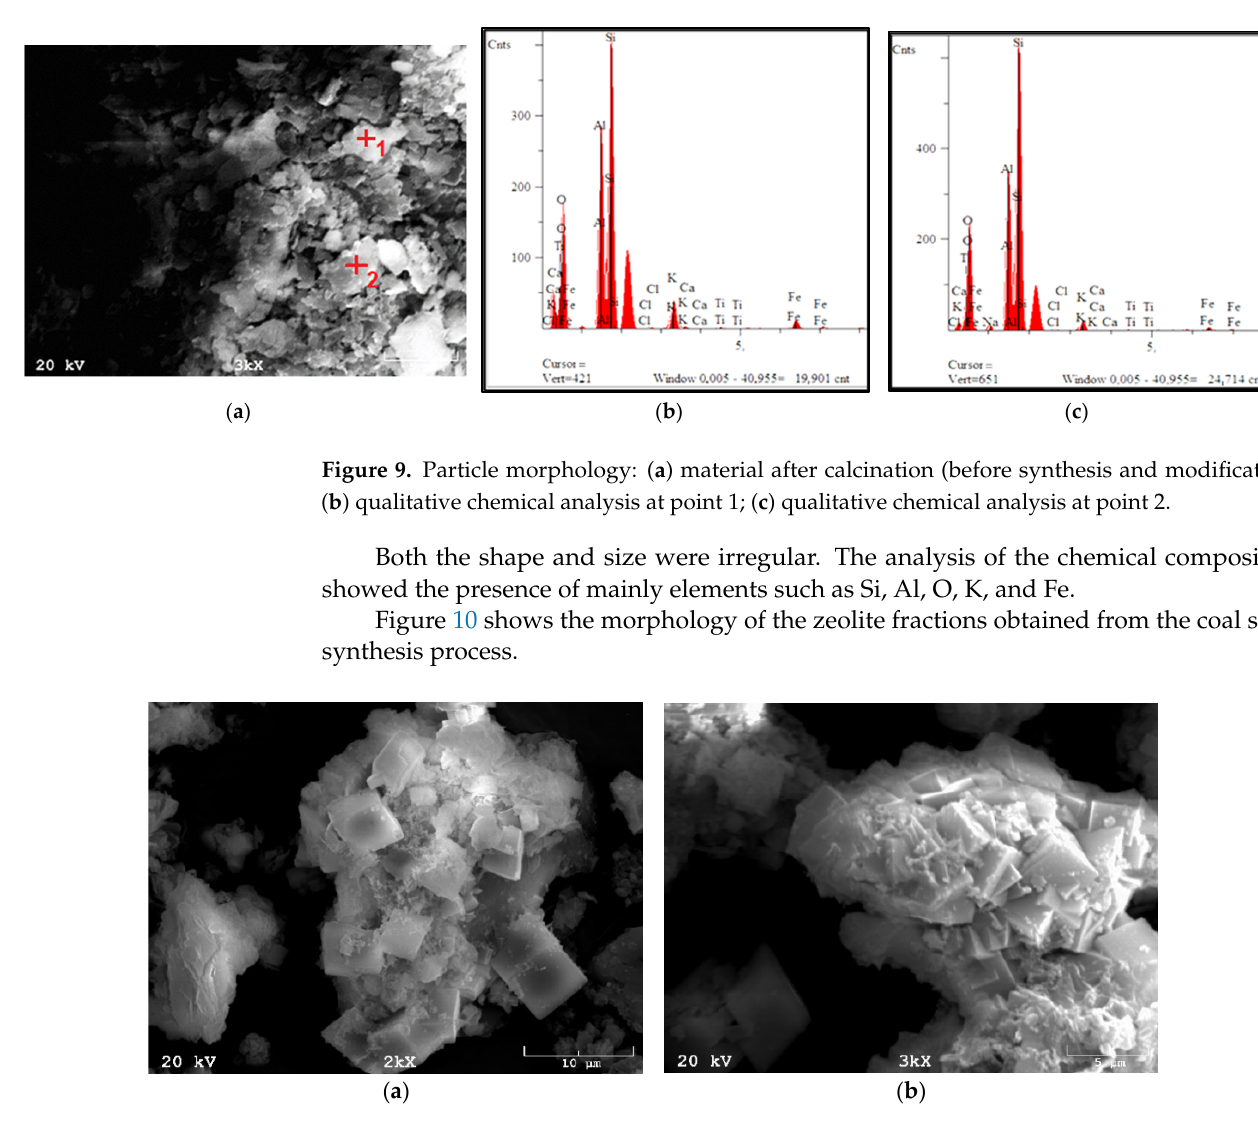
Figure 8. N 2 sorption/desorption isotherm in AS sample.